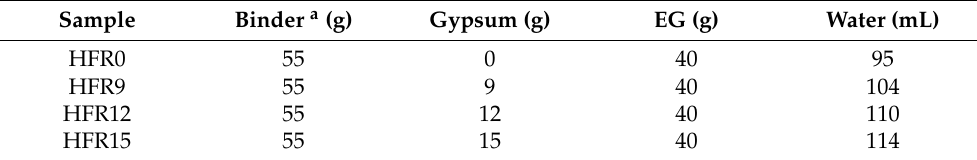
Table 1. The preparative parameters of the gypsum-based HFR